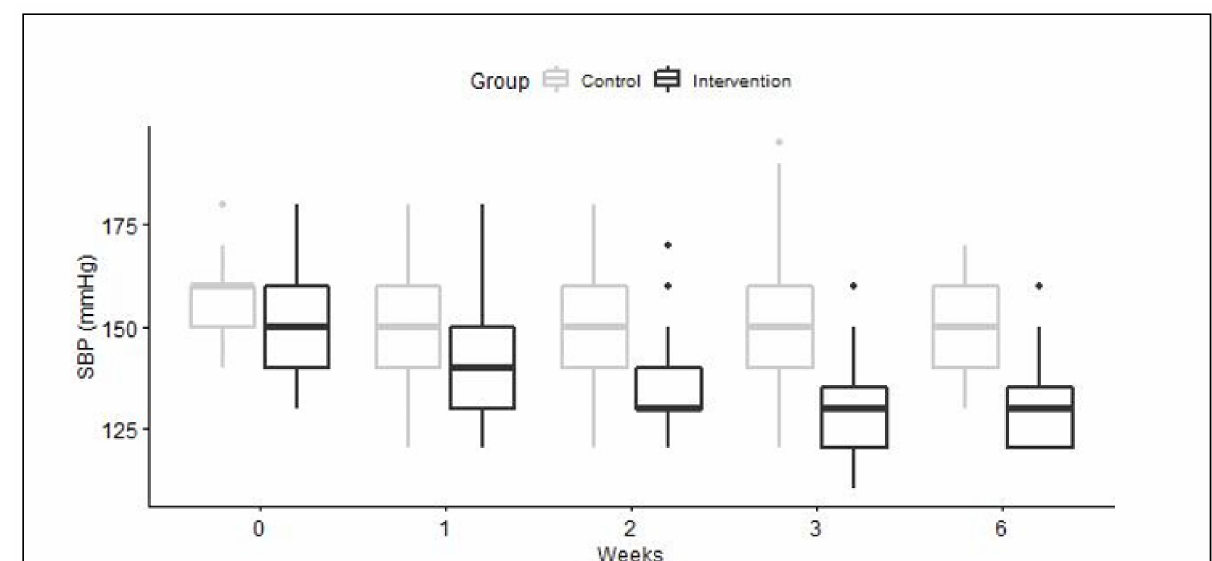
Figure 2. Boxplots of Systolic BP overtime. Median values are black lines in the middle of the box, interquartile range (IQR) is the height of the box; minimum and maximum values (1.5 × IQR) are represented by the lines extending out of the box. The outliers are